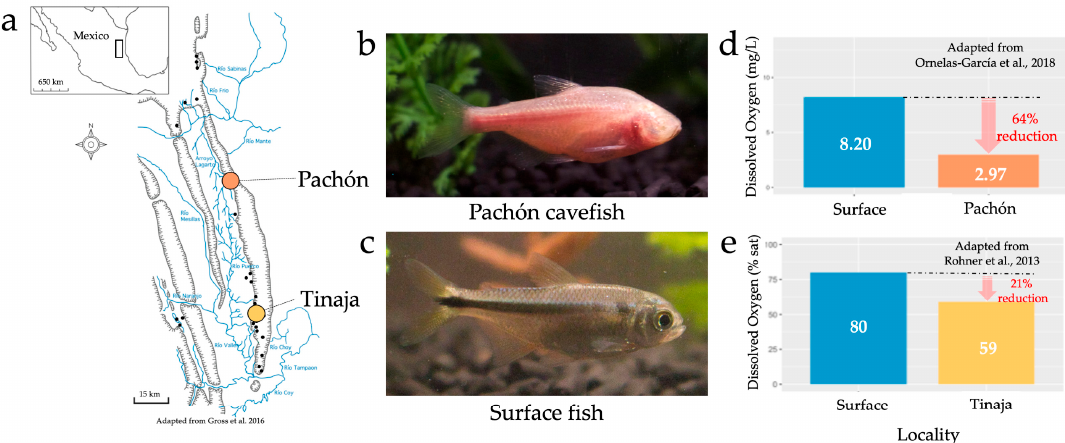
Figure 1. The numerous caves, fish and oxygen measurements found in the Sierra de El Abra and surrounding regions. 30 named caves are located in this region of northeastern Mexico ( a ). The species Astyanax mexicanus is composed of two morphotypes, the cavefish ( b ) and surface fish ( c ). Oxygen measurements taken with the Pach ó n cave ( d ) and Tinaja cave ( e ) show reduced levels of oxygen compared to surrounding surface